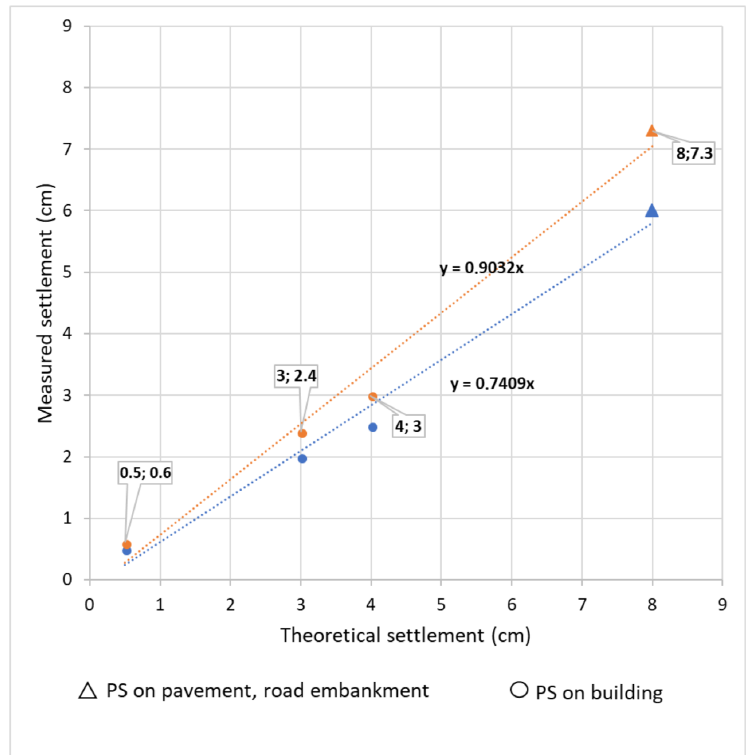
Figure 17. Comparison of theoretical settlements values (obtained by applying the one-dimensional (1D) consolidation theory to known shallow-founded buildings and pavements of known age) with the corresponding COSMO-SkyMed dataset for the period 2011 – 2015. Blue symbols indicate LOS displacements, whereas orange symbols represent the corresponding results converted to the vertical direction. The slopes of the trend line, quite close to the bisector, show the agreement between the physically based estimations and the actual measurements via Persistent Scatterer Interferometry (PSI).